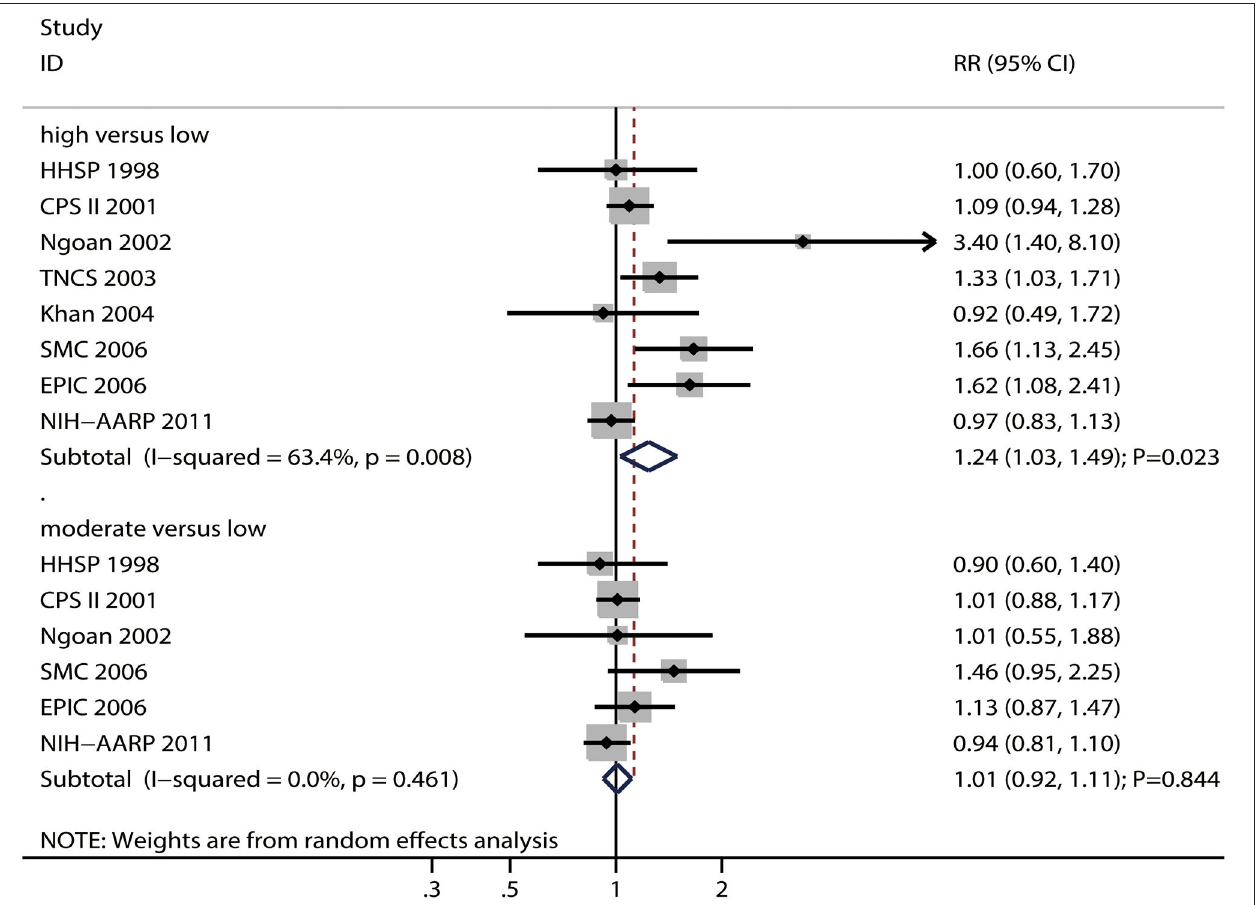
FIGURE 5 | Association between high or moderate processed meat intake and subsequent gastric cancer risk.